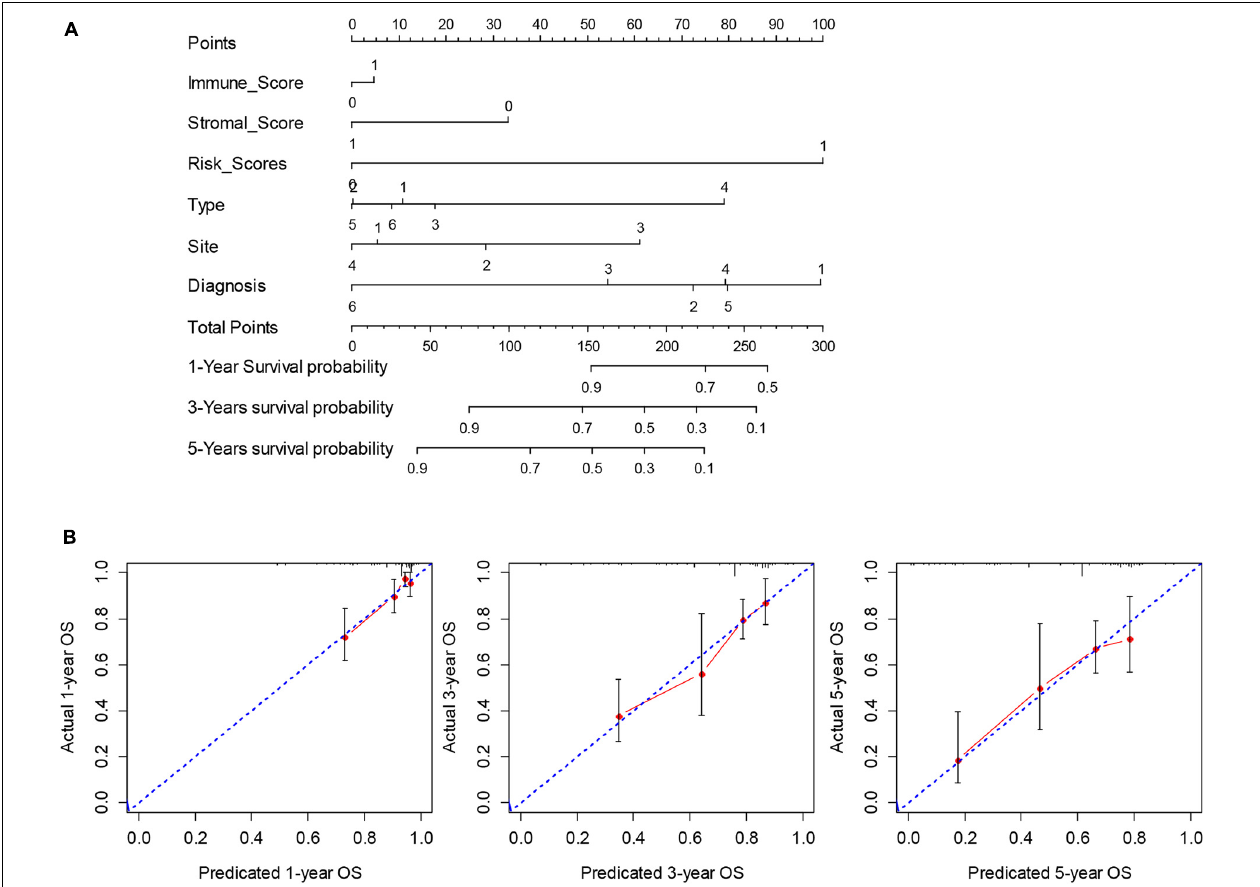
FIGURE 9 | The construction and validation of nomogram. (A) The multivariate Cox model based nomogram of SARC patients; Immune_Score: 0 = Low and 1 = High; Stromal_Score: 0 = Low and 1 = High; Risk_Score: 0 = Low and 1 = High; Type: 1 = Fibromatous Neoplasms, 2 = Lipomatous Neoplasms, 3 = Myomatous Neoplasms, 4 = Nerve Sheath Tumors, 5 = Soft Tissue Tumors and Sarcomas (Not Otherwise Specified) and 6 = Synovial-like Neoplasms; Diagnosis: 1 = Dedifferentiated liposarcoma, 2 = Fibromyxosarcoma, 3 = Leiomyosarcoma (Not Otherwise Specified), 4 = Malignant fibrous histiocytoma, 5 = Undifferentiated sarcoma and 6 = Others; Site: 1 = Connective, subcutaneous and other soft tissues, 2 = Retroperitoneum and peritoneum, 3 = Uterus (Not Otherwise Specified) and 4 = Others; (B) the calibration plots for the internal validation of current nomogram, the x -axis represents the nomogram predicted overall survival and the y -axis represents the actual overall survival of patients with SARC.